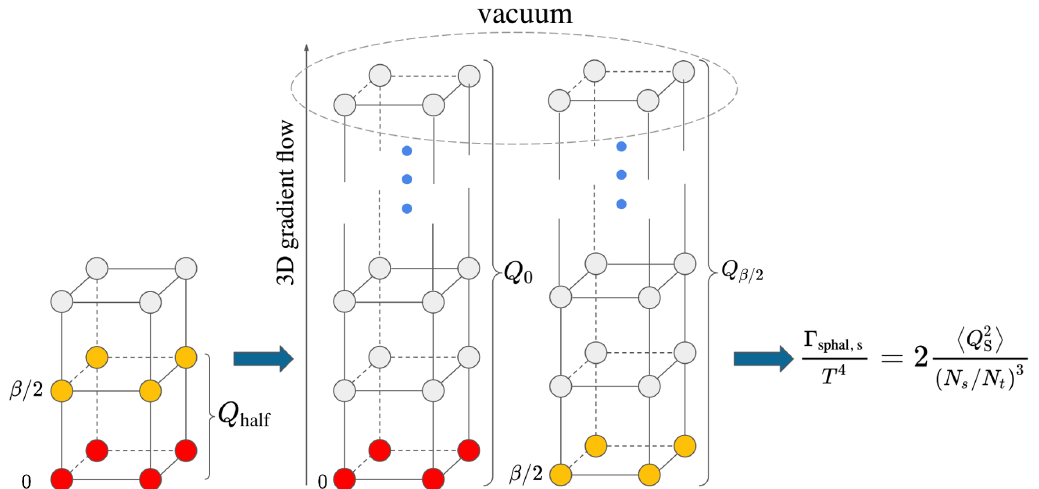
Figure 6 . Sketch of the calculation performed on the lattice to determine the sphaleron rate. One dimension of the lattice is left not drawn for